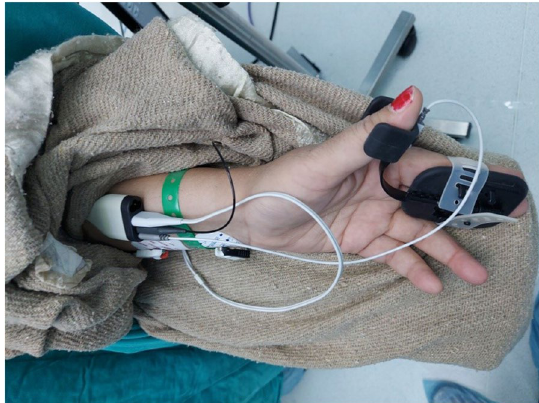
Fig. 1 Neuromuscular monitoring using TOF stimulation